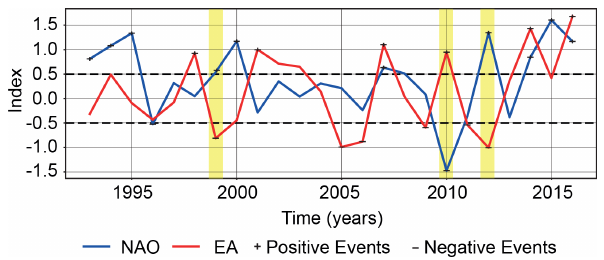
Figure 4. Winter means of NAO and EA. Positive and negative phases are marked with + and − , respectively; combined opposite phases are marked in